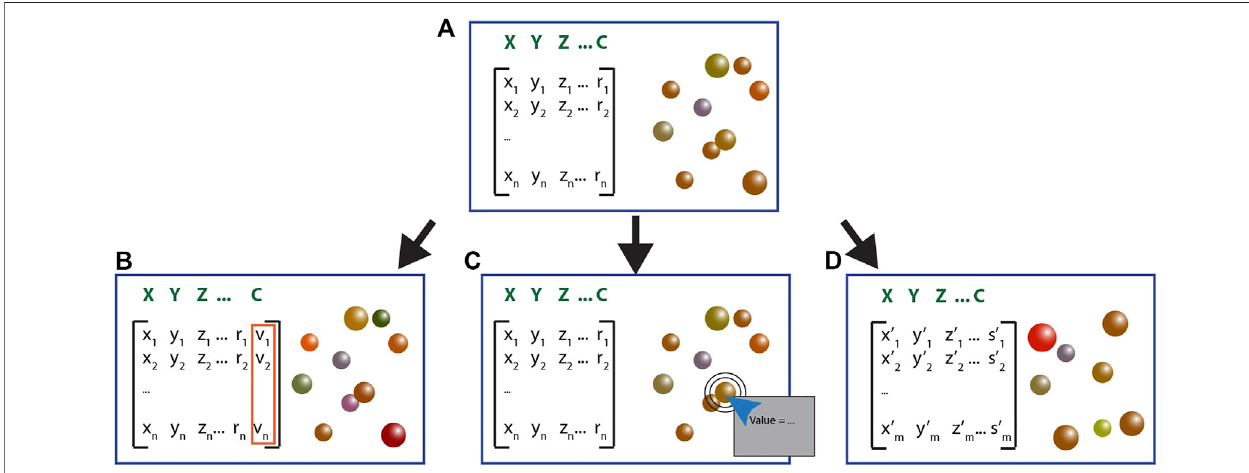
FIGURE 3 | Different library con fi gurations are compatible with Genuage and allow performing speci fi c manipulation of the data. (A) Initially, the point cloud is imported as a table of coordinates displays in Genuage as 3D spheres positioned at (X,Y,Z) coordinates with speci fi c visual attributes like colors (c). Depending on its format, the DLL: (B) performs a speci fi c calculation on the point cloud that results in an additional data column that could be assigned to a speci fi c visual feature, (C) retrieves the information from selected points. It displays the resulting calculus in a popping up window, (D) generates an entirely new point cloud with different elements based on speci fi c mathematic